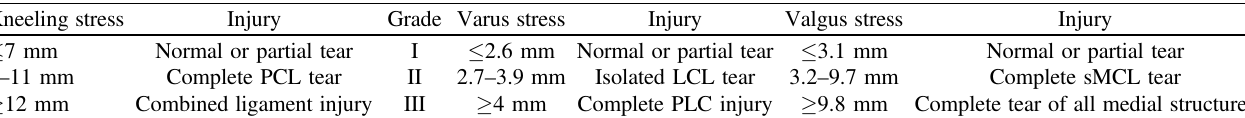
Table 3. Evaluation of posterior, varus, and valgus knee instability using stress radiographs [3]. Kneeling stress Injury Grade Varus stress Injury Valgus stress Injury (cid:1) 7 mm Combined ligament injury Complete tear of all medial structures LCL, lateral collateral ligament; PCL, posterior collateral ligament; PLC, posterolateral corner; PTT, posterior tibial translation; sMCL, super fi cial medial collateral